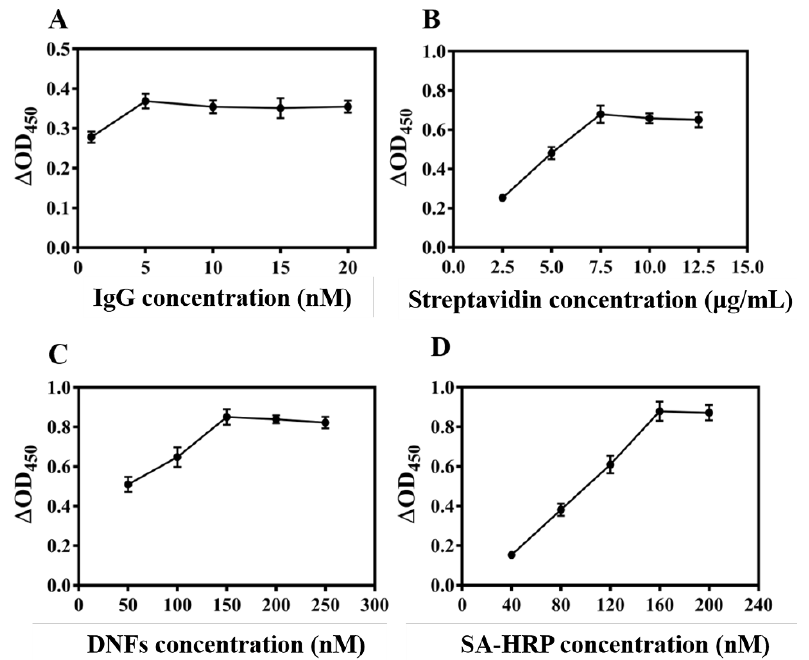
Figure 4. The AMS-DNFs amplification colorimetric method parameters’ optimization. ( A ) Optimization of biotin-IgG concentration. ( B ) Optimization of SA concentration. ( C ) Optimization of DNFs concentration. ( D ) Optimization of SA-HRP concentration. The concentration of S. aureus was 3.3 × 10 5 CFU/mL. The error bars represent the standard deviation of three measurements.